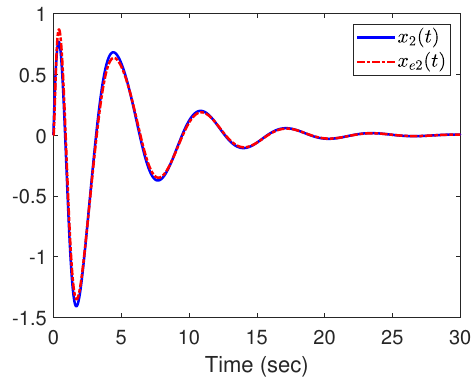
Figure 3. The trajectories of x 2 ( t ) and x e 2 ( t ) .